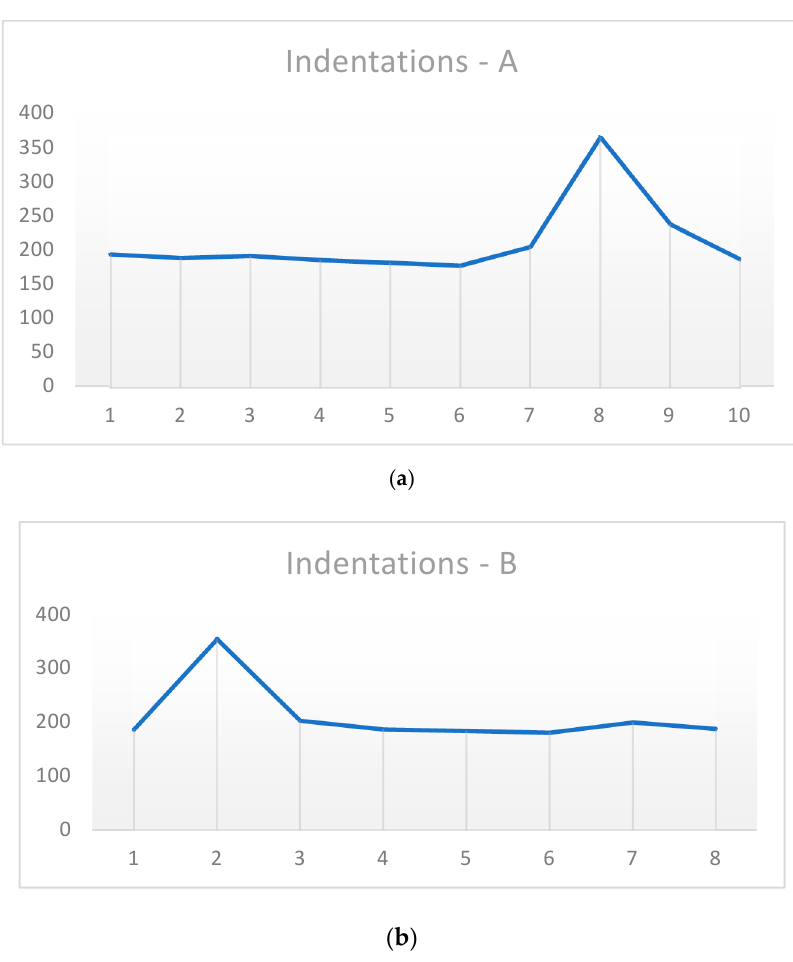
Figure 10. Indentations on the sample 1P0W2P400 after rupture: ( a ) side A and ( b ) side B.